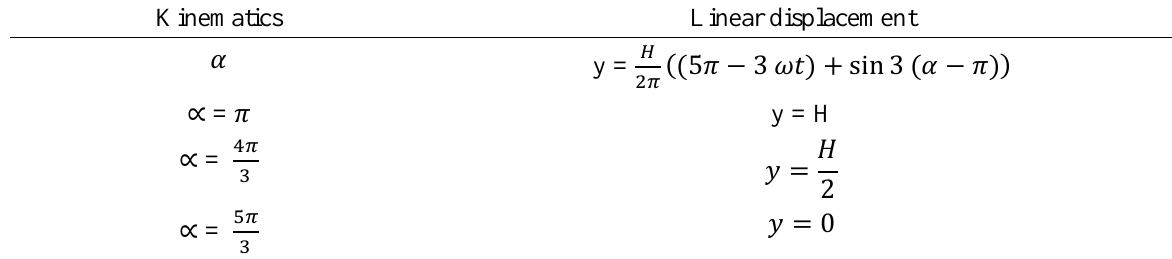
Table 3. Summary of the kinematic motion of the follower during the return stage